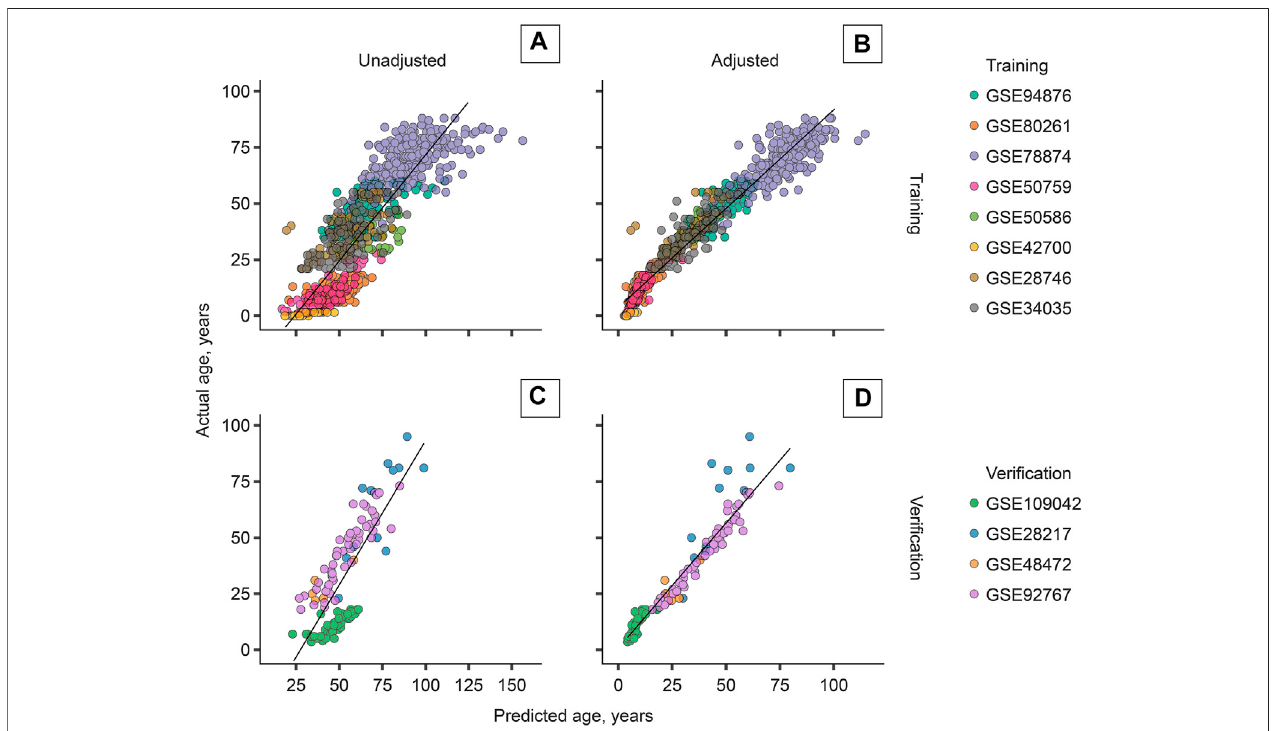
FIGURE 2 | Cell-type adjustment ( “ total age-transformed ” ) signi fi cantly improves the performance of DeepMAge (originally developed for blood samples) in the domain of saliva samples. (A) Training set, unadjusted: R 2 (cid:1) 0.73. (B) Training set, adjusted: R 2 (cid:1) 0.95. (C) Veri fi cation set, unadjusted: R 2 (cid:1) 0.63. (D) Veri fi cation set, adjusted: R 2 (cid:1) 0.92. R 2 (cid:1) coef fi cient of determination. Predictions for the training set were obtained with leave-one-study-out